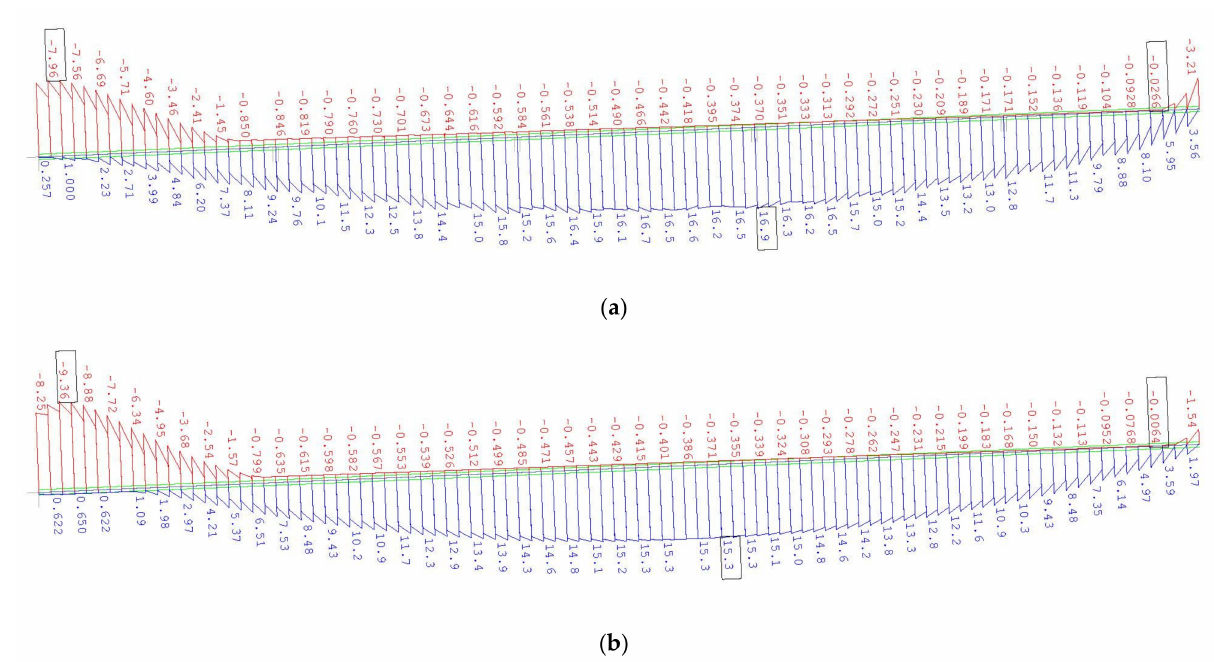
Figure A6. Characteristic values of bending moments M (kNm) under the moving load K of class C in the right span: ( a ) Outer girder; ( b ) inner girder.